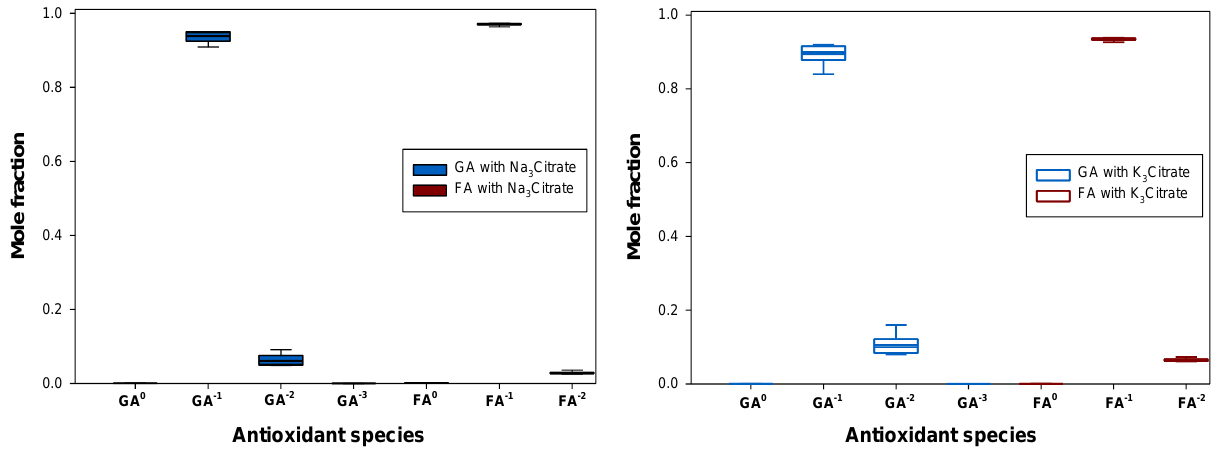
Figure 6. Effect of the tie-line compositions in the calculated mole fractions of the antioxidant stages of gallic acid (GA) and ferulic acid (FA) in the ATPS {ethyl lactate (1) + trisodium citrate ( left ) or tripotassium citrate ( right ) (2) + water (3)} at 298.15 K and 0.1 MPa. GA 0 , GA − 1 , GA − 2 and GA − 3 refer to the antioxidant stages of gallic acid with electrical charges equal to 0, − 1, − 2, − 3 and − 4 e, respectively; FA 0 , FA − 1 and FA − 2 refer to the antioxidant stages of ferulic acid with electrical charges equal to 0, − 1 and −2 e, respectively, and e stands for the elementary charge (1.602∙10 − 19 C).